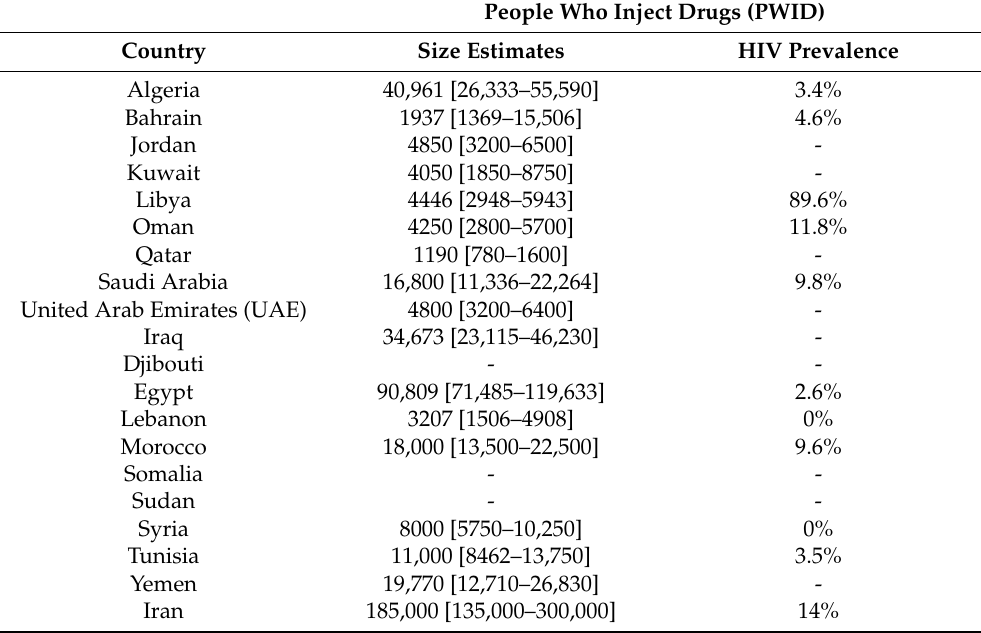
Table 2. Population size and HIV prevalence in people who inject drugs (PWID) within each country of the MENA region